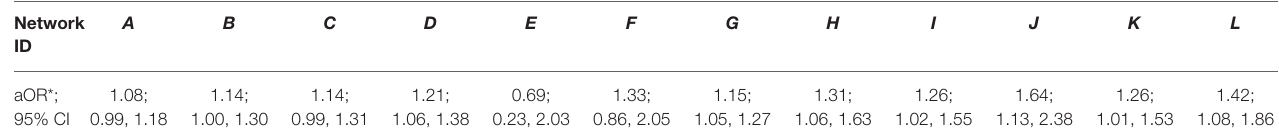
TABLE 5 | Multivariable logistic regression analyses of the association between patient’s weight category and AD prescribing among CPCSSN patients with depression, according to networks. Network